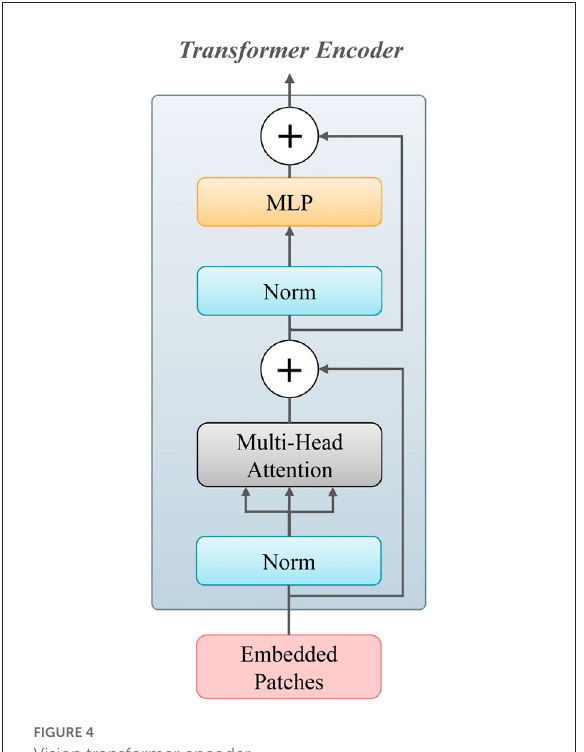
FIGURE4 Vision transformer encoder.